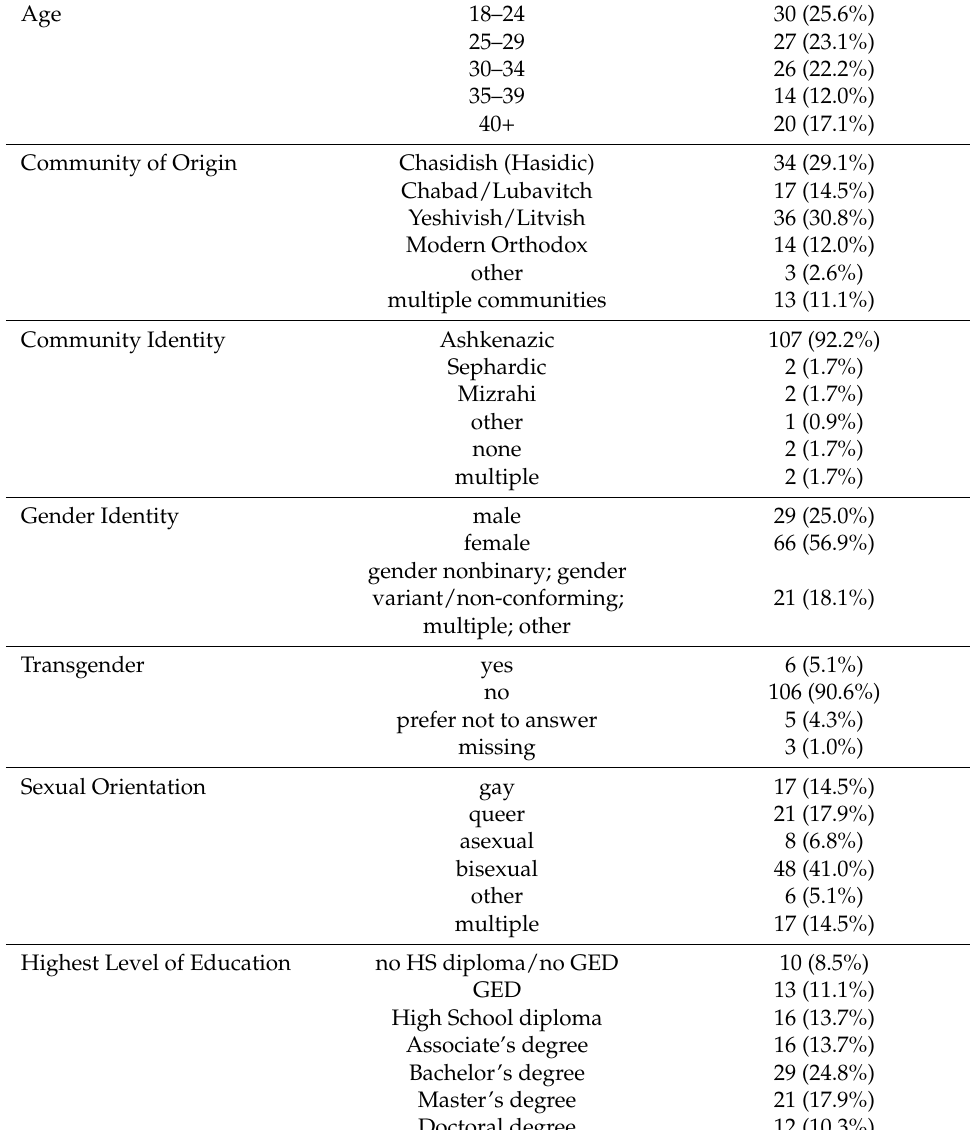
Table 2. Demographic information for religiously disaffiliated LGBTQ+ individuals providing responses to two questions of interest related to religious disaffiliation (N =